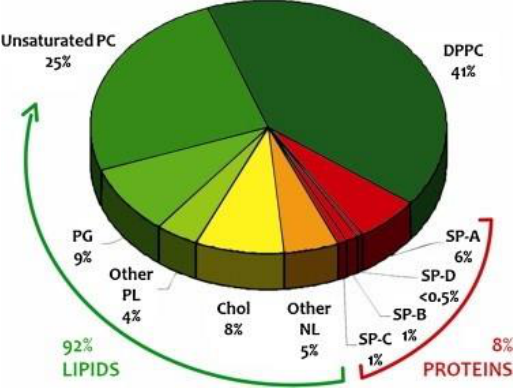
Figure 1. Average composition, as percentage in relation to the total weight, of mammal LS. PL: phospholipids; PC: phosphatidylcholines; PG: phosphatidylglycerol; Chol: cholesterol; NL: neutral lipids; SP-A/B/C/D: surfactant protein A/B/C/D. Reprinted from Parra and Pérez-Gil [24] , with permission from Elsevier, Copyright 2015.